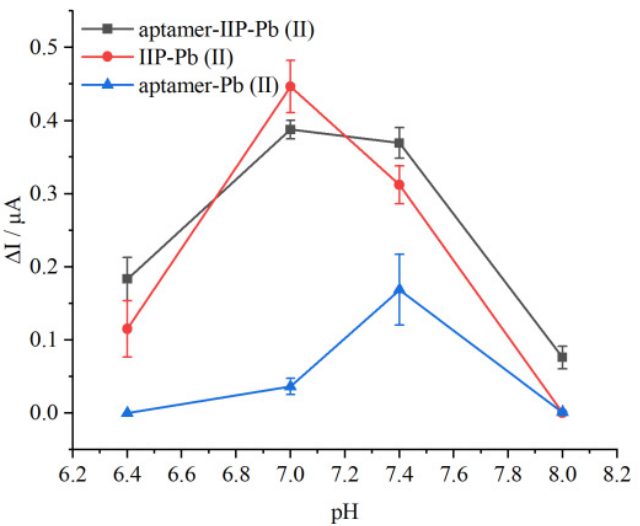
Figure 5. Stability of aptamer-IIP-Pb(II), aptamer-Pb(II), and IIP-Pb(II) sensors for detecting 1 µ M Pb(II) in different pH (6.4, 7.0, 7.4m, and 8.0). Table 1. Determination of Pb(II) in three mantis shrimp samples ( n =